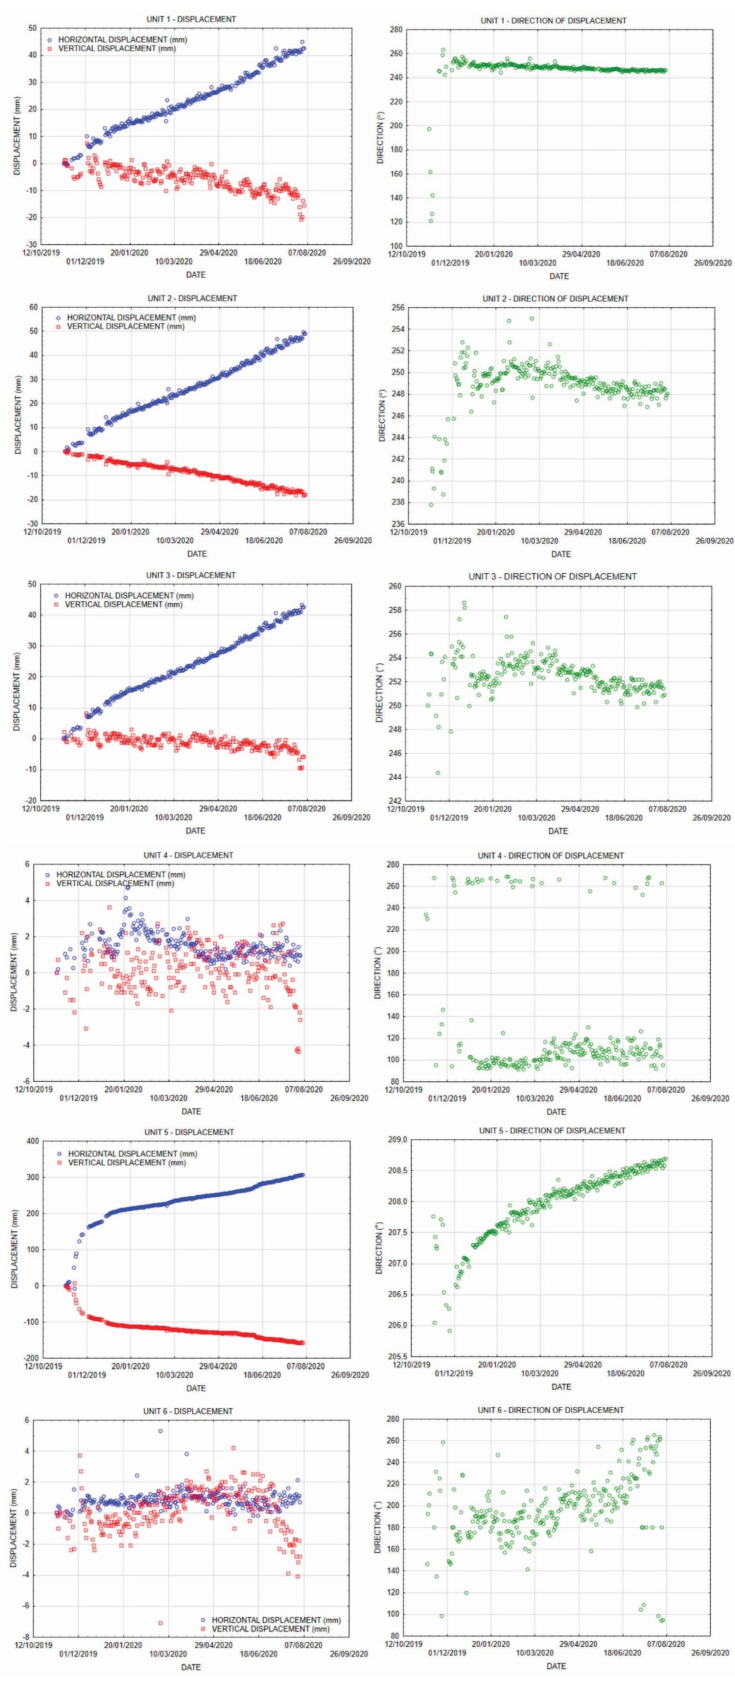
Figure 10. Time series of horizontal and vertical displacements, and the direction of the displacements. Note the di ff erent